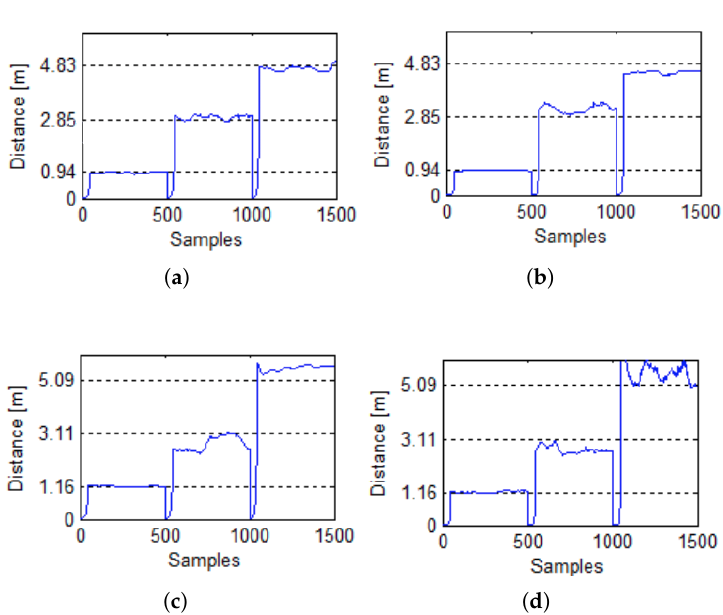
Figure 10. Results of the distance estimation analysis: ( a ) from three different distances of the UAV to sensing module A, ( b ) the same distances of the UAV to sensing module B, ( c ) results of the distance estimation from UAV to sensing module C, and ( d ) UAV to sensing module